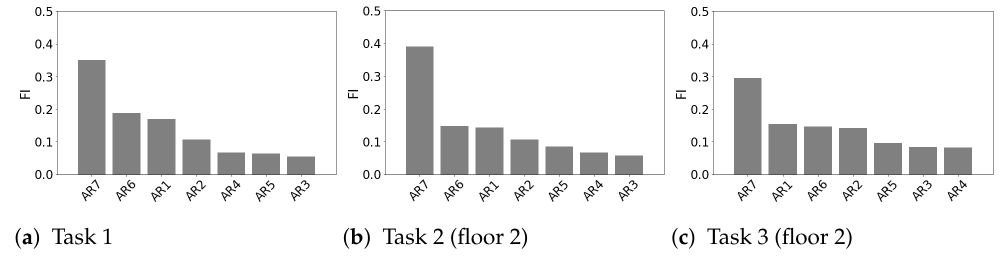
Figure 14. FI score of features extracted by the ARI(7,1)